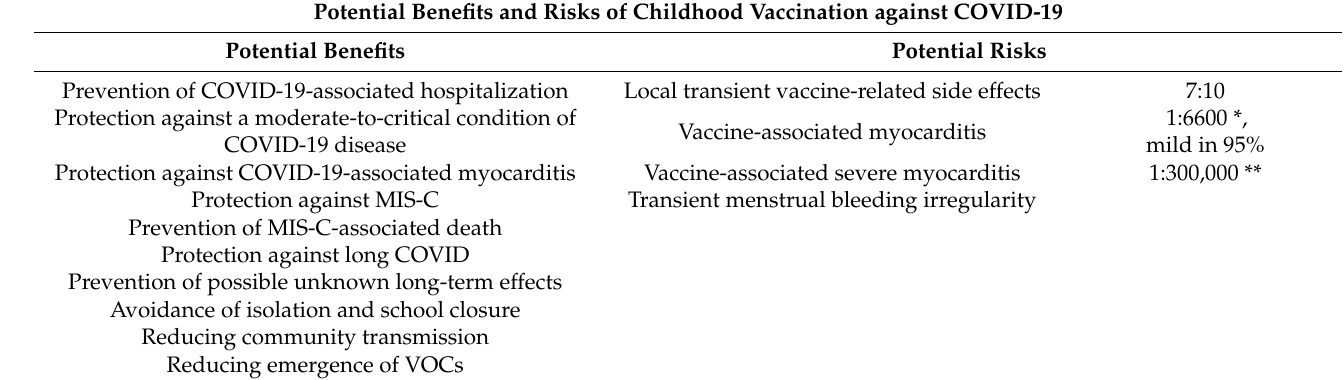
Table 1. Summary of benefits and risks of vaccination of children against